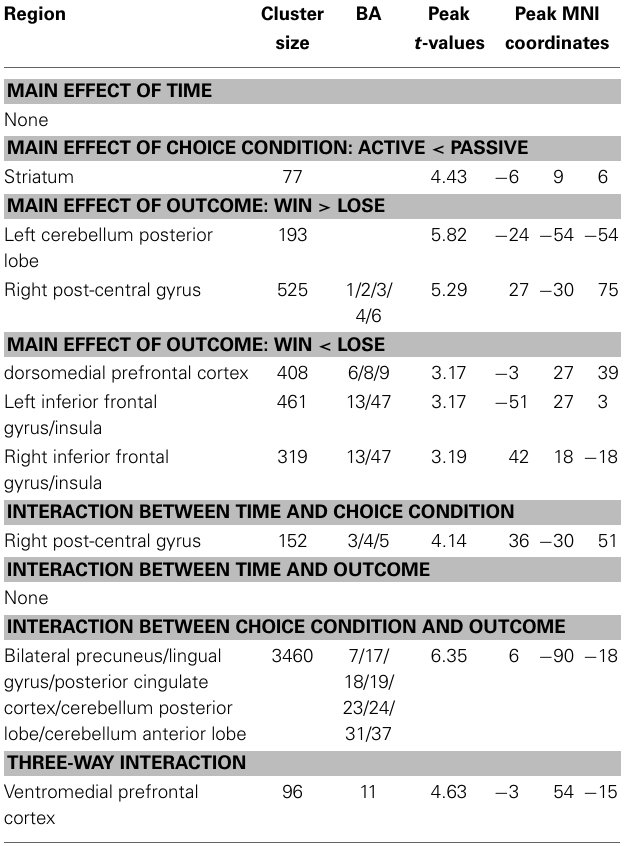
bed rest. No significant difference between before and after bed rest was found in the passive choice condition. Error bar denotes the standard error.